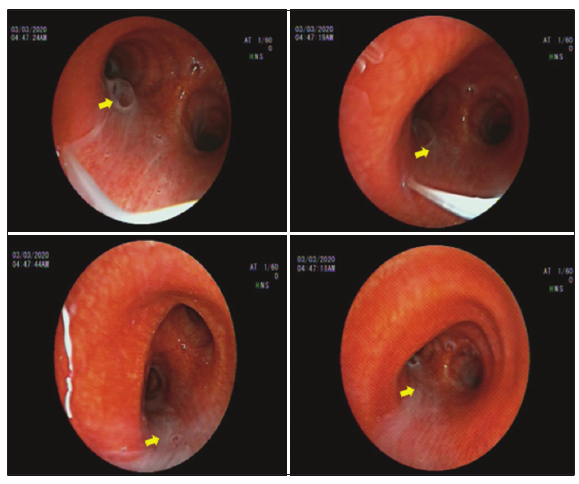
FIGURE 3. Bronchus branches and bronchoalveolar lavage fluid with milky appearance (yellow